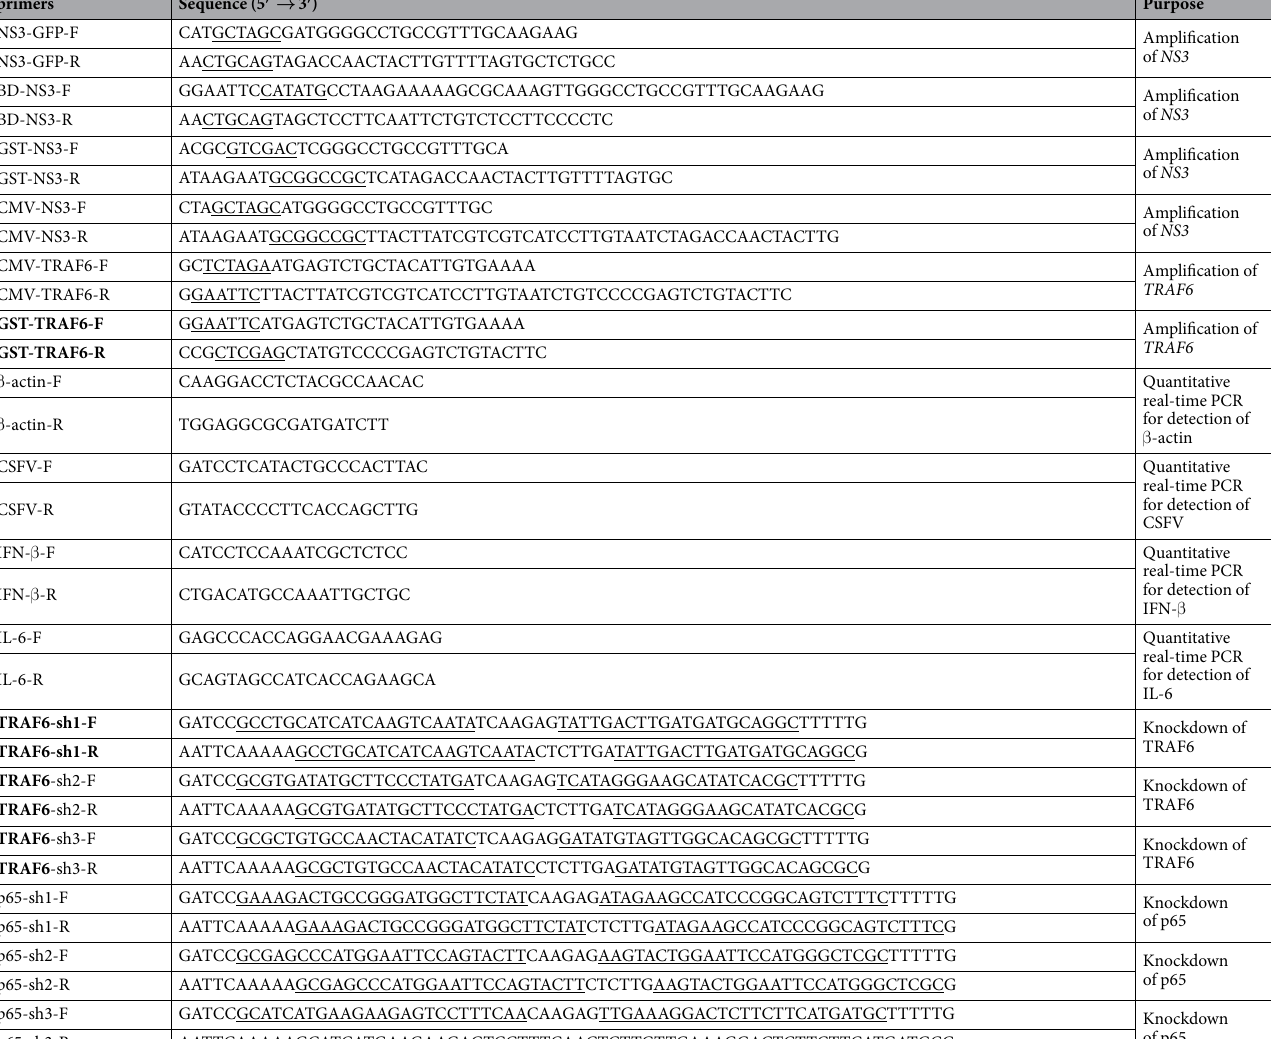
Table 2. Primers used in this